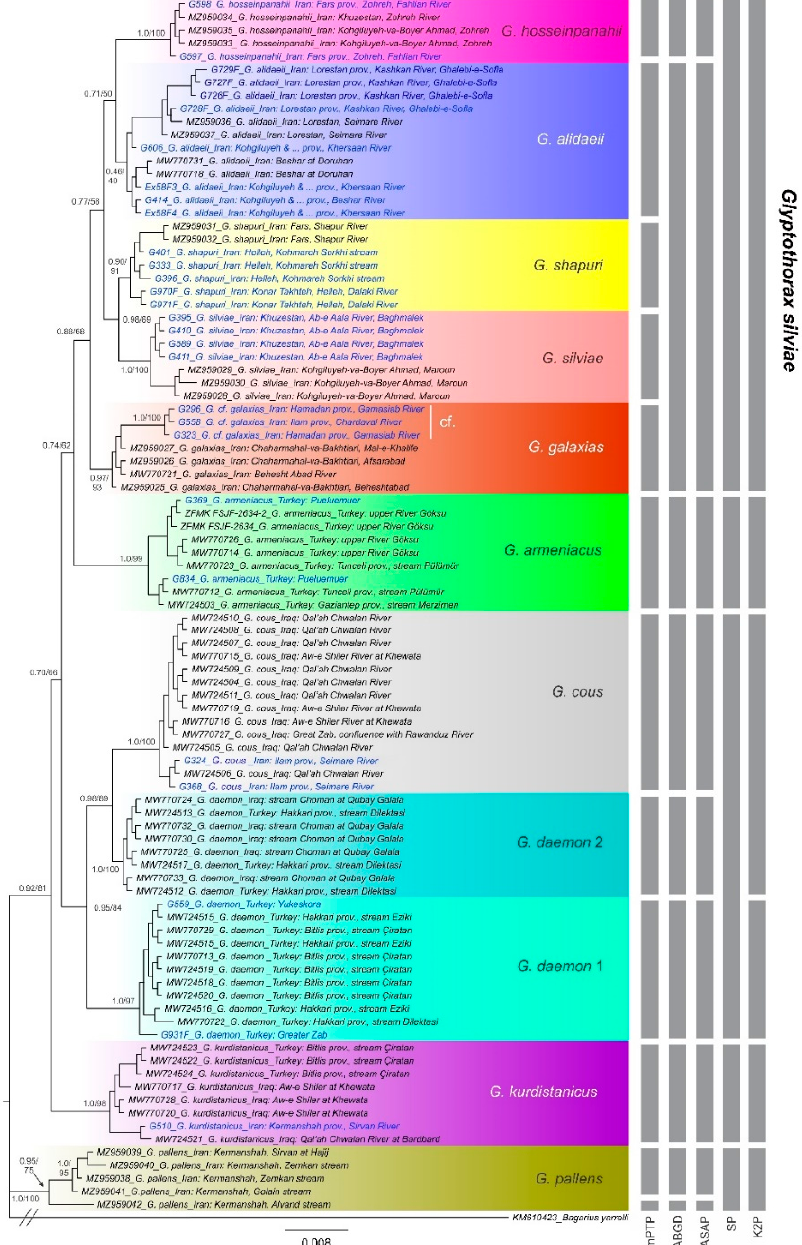
Figure 2. Bayesian (BI) and Maximum Likelihood (ML) tree of the genus Glyptothorax from the Middle East based on COI dataset, showing the phylogenetic placements of the new samples from Iran and Turkey (taxa with a blue font) and results of five molecular species delimitation methods (gray bars on the right): mPTP, multiple-rate Poisson Tree Process; ABGD, Automatic Barcode Gap Discovery; ASAP, Assemble Species by Automatic Partitioning; SP, reversed Statistical Parsimony; K2P, species delimitation based on the K2P distance new species threshold value (i.e., 2%). Support values are indicated beside the nodes [BI posterior probability/ML bootstrap (PP/BP)].